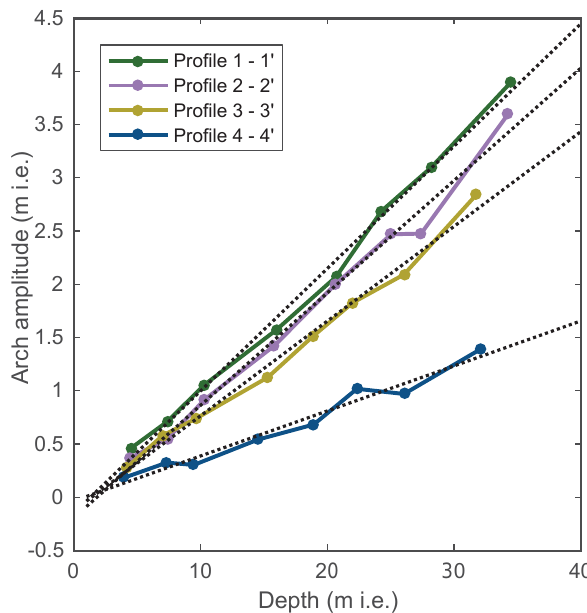
Figure 5. Depth variations of upward-arch amplitudes observed near the summit (Fig. 2b) along four radar profiles (Fig. 1b). Filled circles show the arch amplitudes and dotted lines show the linear